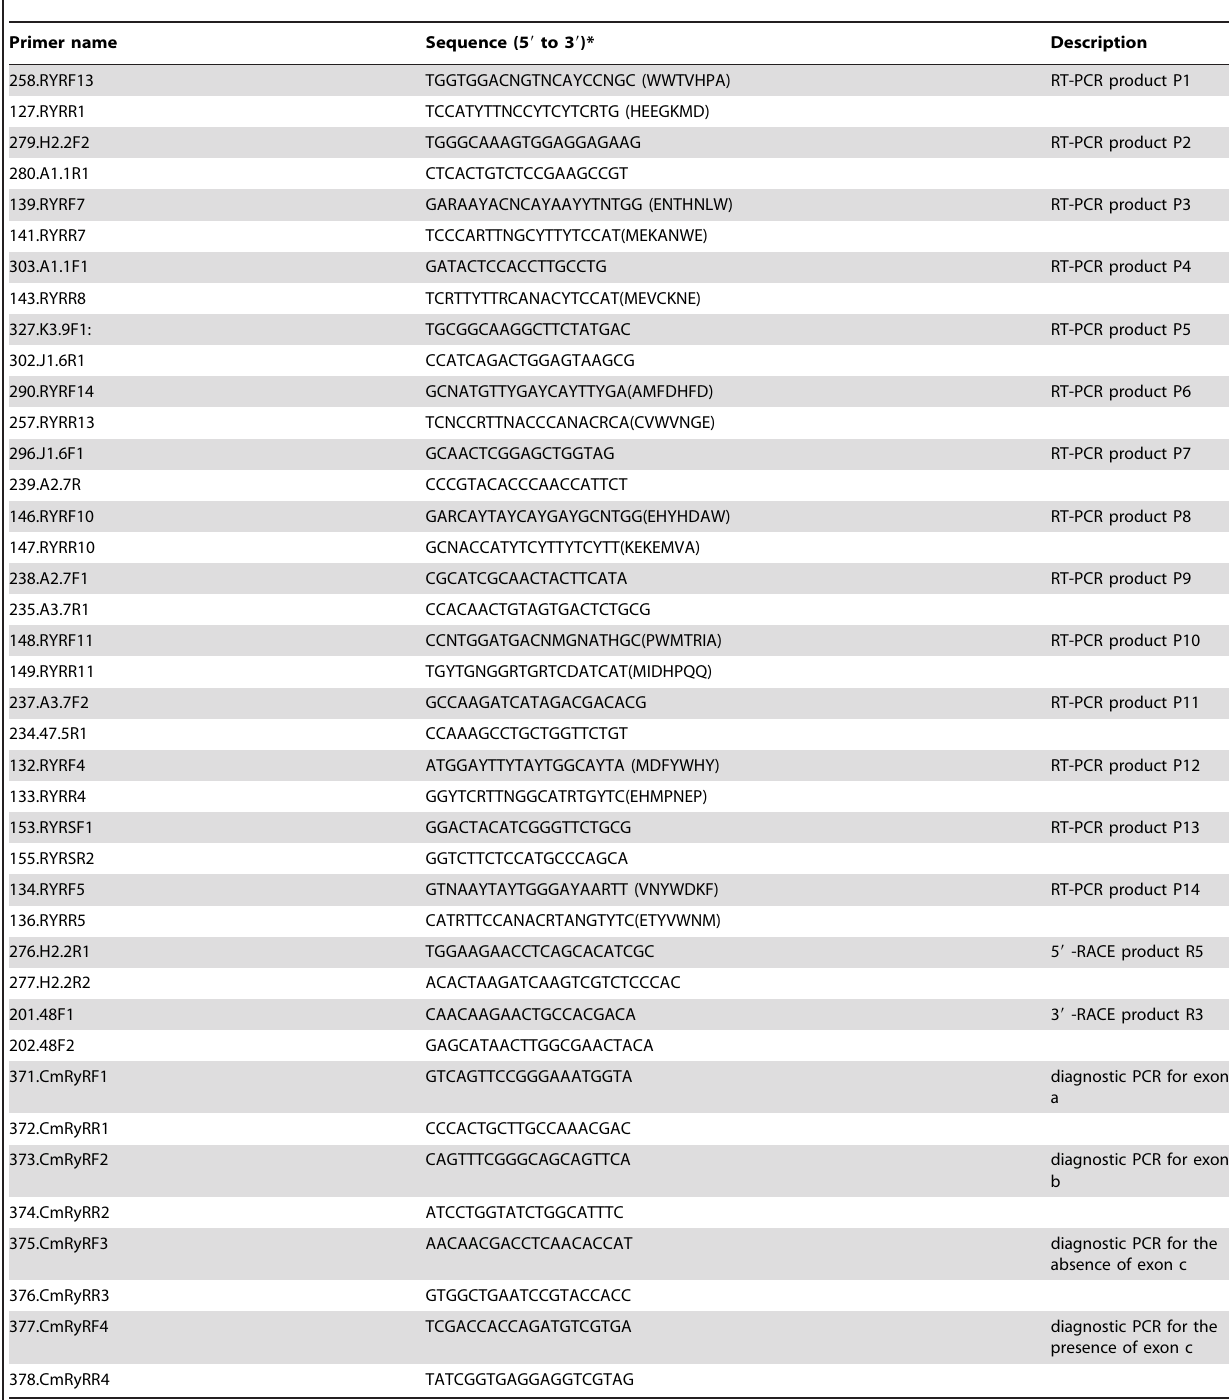
Table 1. Oligonucleotide primers used for RT-PCR, RACE and diagnostic